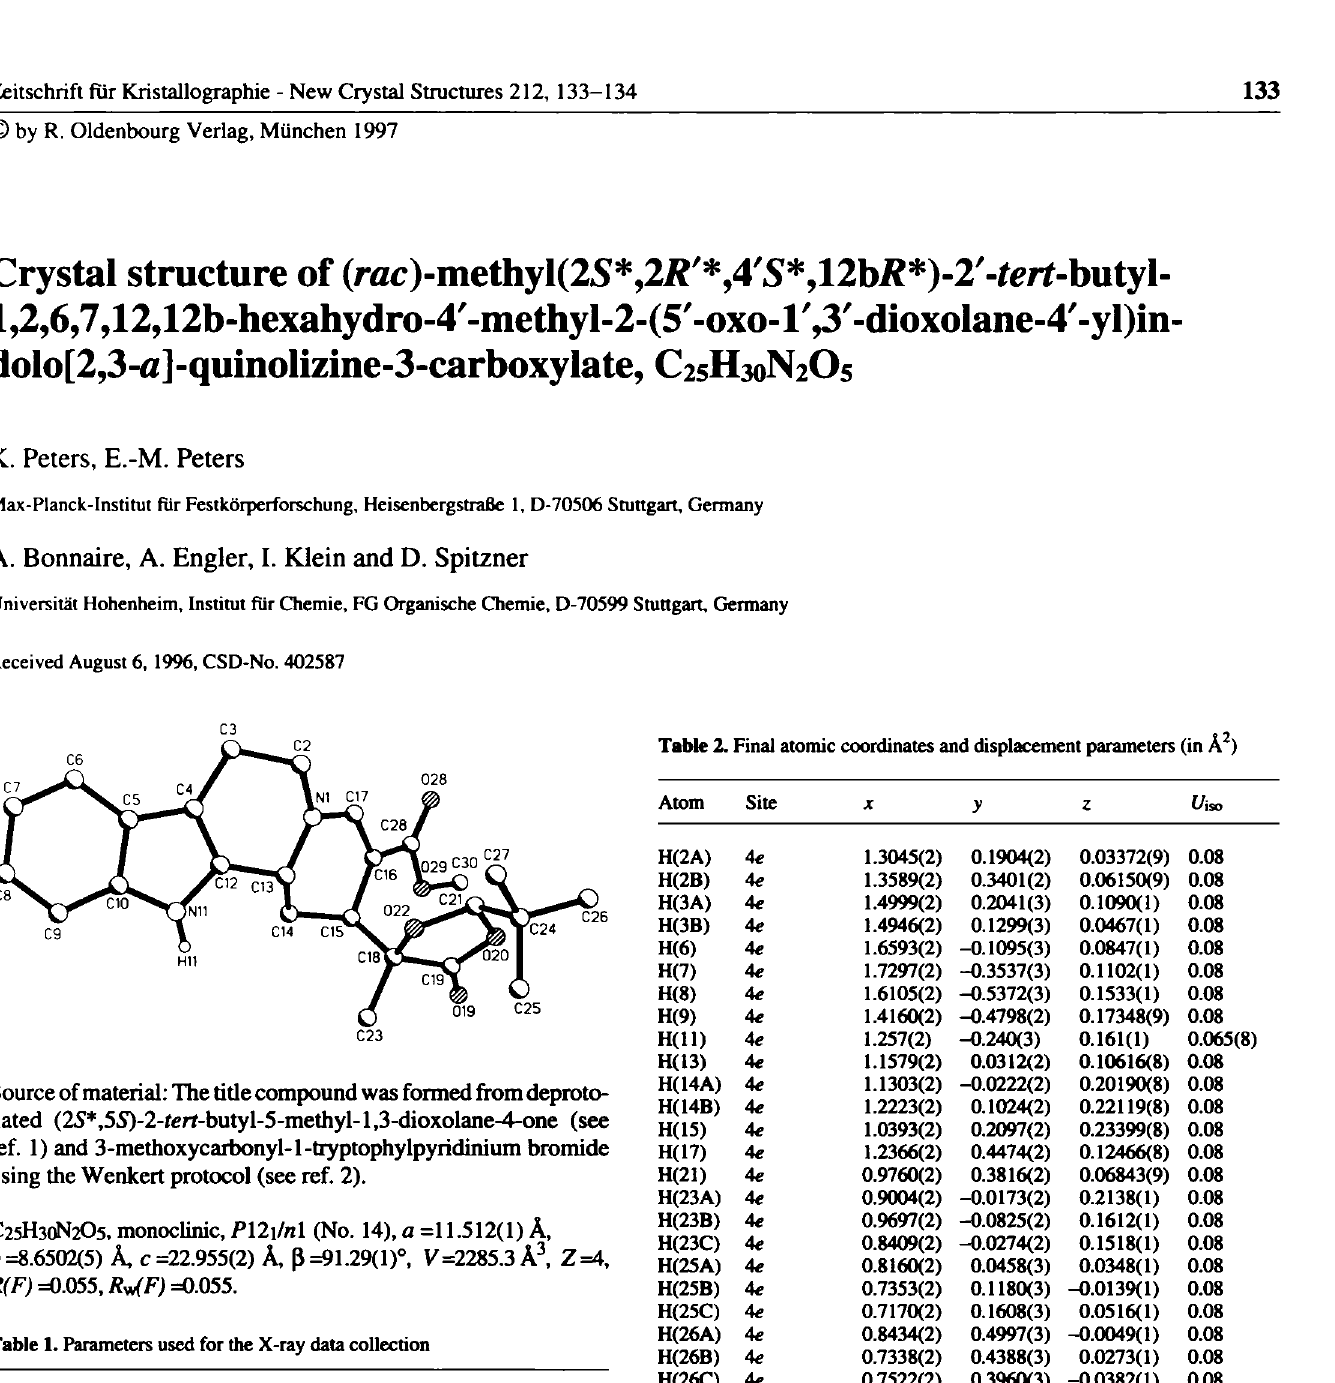
Table 1. Parameters used for the X-ray data collection